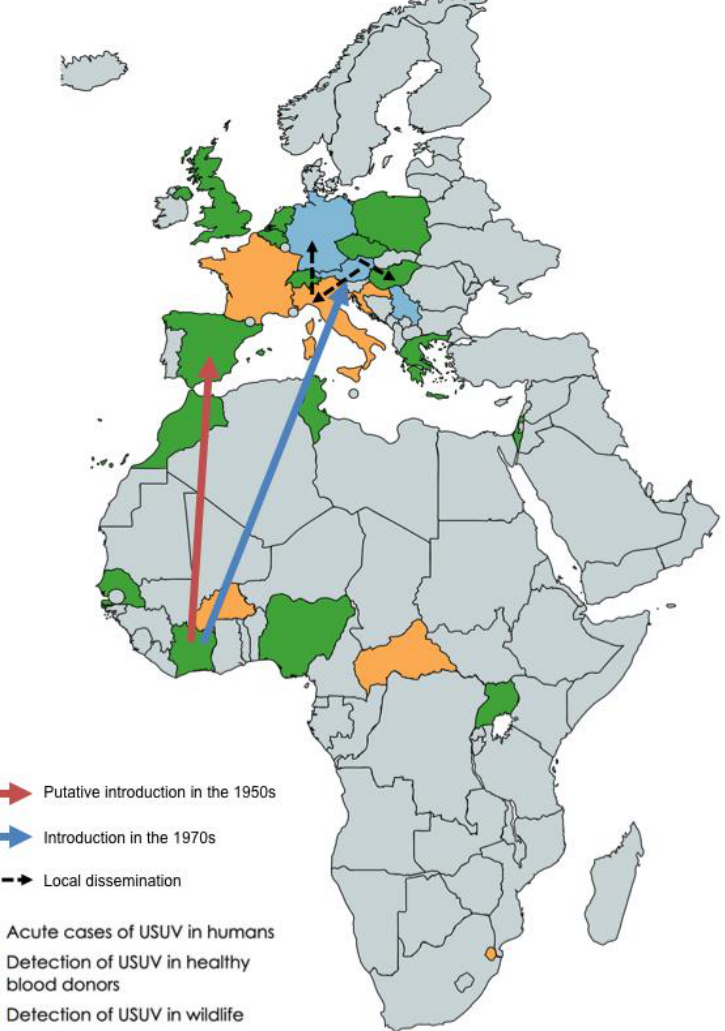
Figure 2. Geographical distribution of USUV. Countries where USUV was detected in wildlife (birds, mosquitoes, horses, etc.) are indicated in green; countries where USUV was detected in healthy blood donors are represented in blue; and countries where USUV caused symptomatic, acute infections are shown in orange. The arrows represent the presumed bird migration event that led to introduction of USUV in Europe, according to Engel et al. [7].